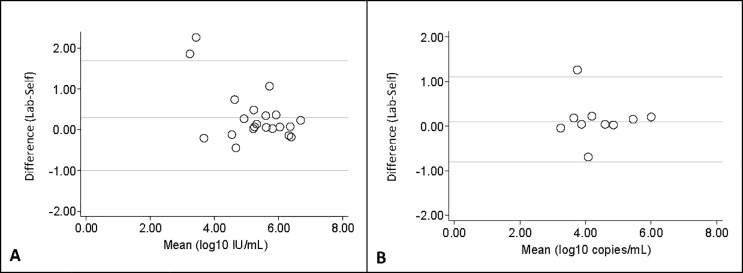
Bland-Altman analysis comparing the labDBS and ssDBS viral load measurements to their mean.The solid line in the middle represents the mean difference between labDBS (laboratory sampled dried blood spots) and ssDBS (self-sampled dried blood spots) viral loads, while the lower and upper lines are for the limits of agreement (± 2 standard deviations). (A)HCV loads: 2 values lie outside the limits of agreement; (B) HIV-1 loads: one value lies outside the limits of agreement.